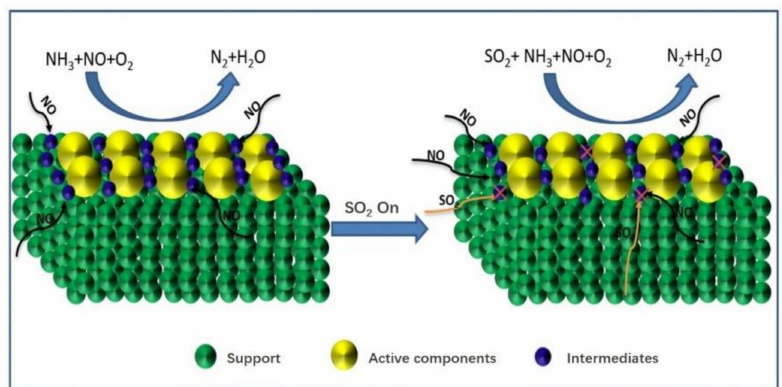
Figure 3. Competitive adsorption of NO and SO